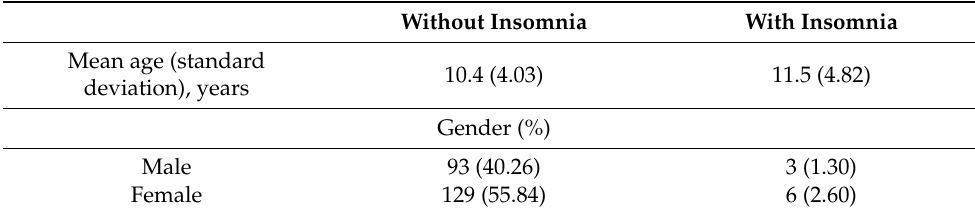
Table 1. Demographic characteristics of the included participants.